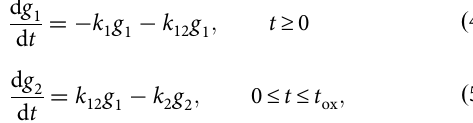
juxtaposition of ( a ) and ( b ) shows how partial oxidation impedes the biopolymer ’ s accessibility to microbial enzymes and enhances its potential for long-term